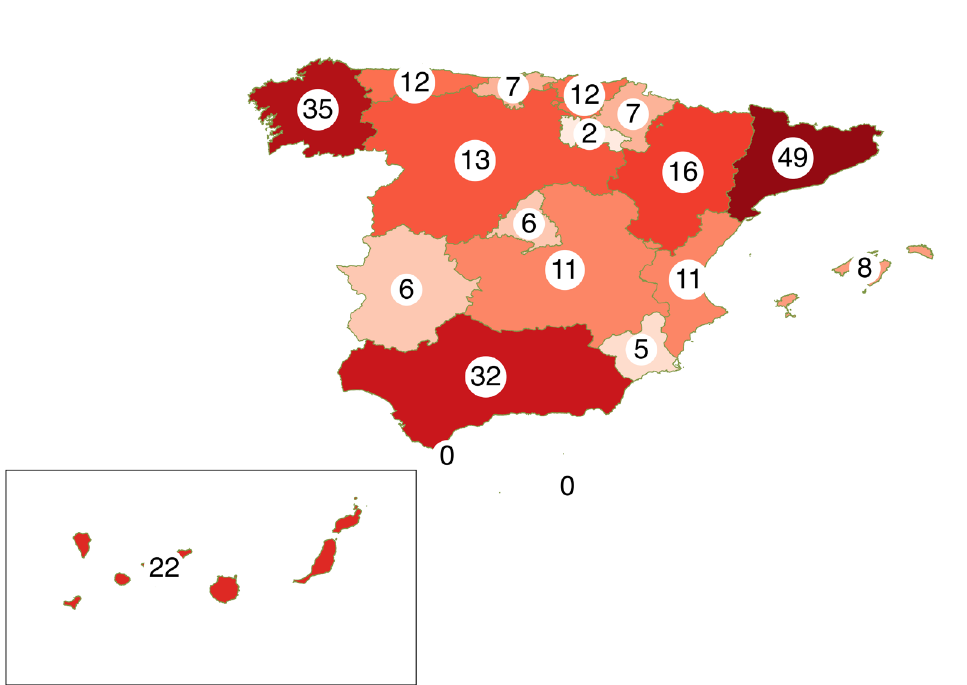
Figure 2. Number of bryophyte species present in national or regional catalogues, distributed by autonomous communities, should the proposal for incorporation into LESRPE and CEEA be accepted. Note that the figures show the sum of species present in each regional catalogue, plus the number of species nationally protected (present in LESRPE/CEEA after the proposal) living in the